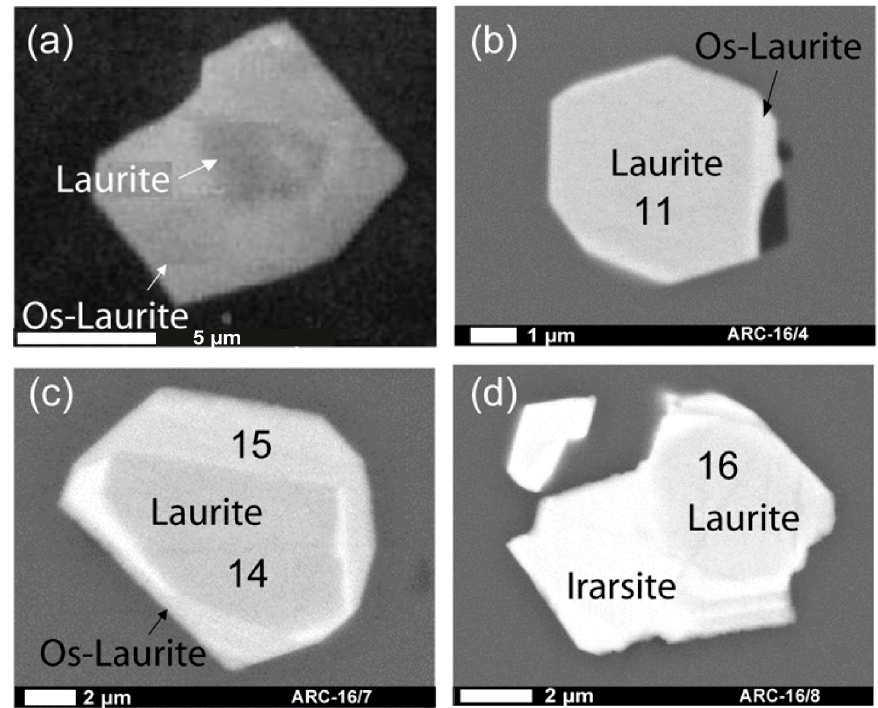
Figure 2. Backscattered electron images of zoned laurites from the Ojén ultramafic Massif. ( a ) euhedral laurite with normal zoning enclosed in chromite (ARC) [21]; ( b , c ) subhedral-euhedral normal zoned laurites with Os-rich cores included within the chromite matrix, (ARC from this study); ( d ) anhedral grain with oscillatory zoning composed of laurite and irarsite (ARC) from this study. Numbers in b, c and d correspond to EPMA results showed in the Table 1.